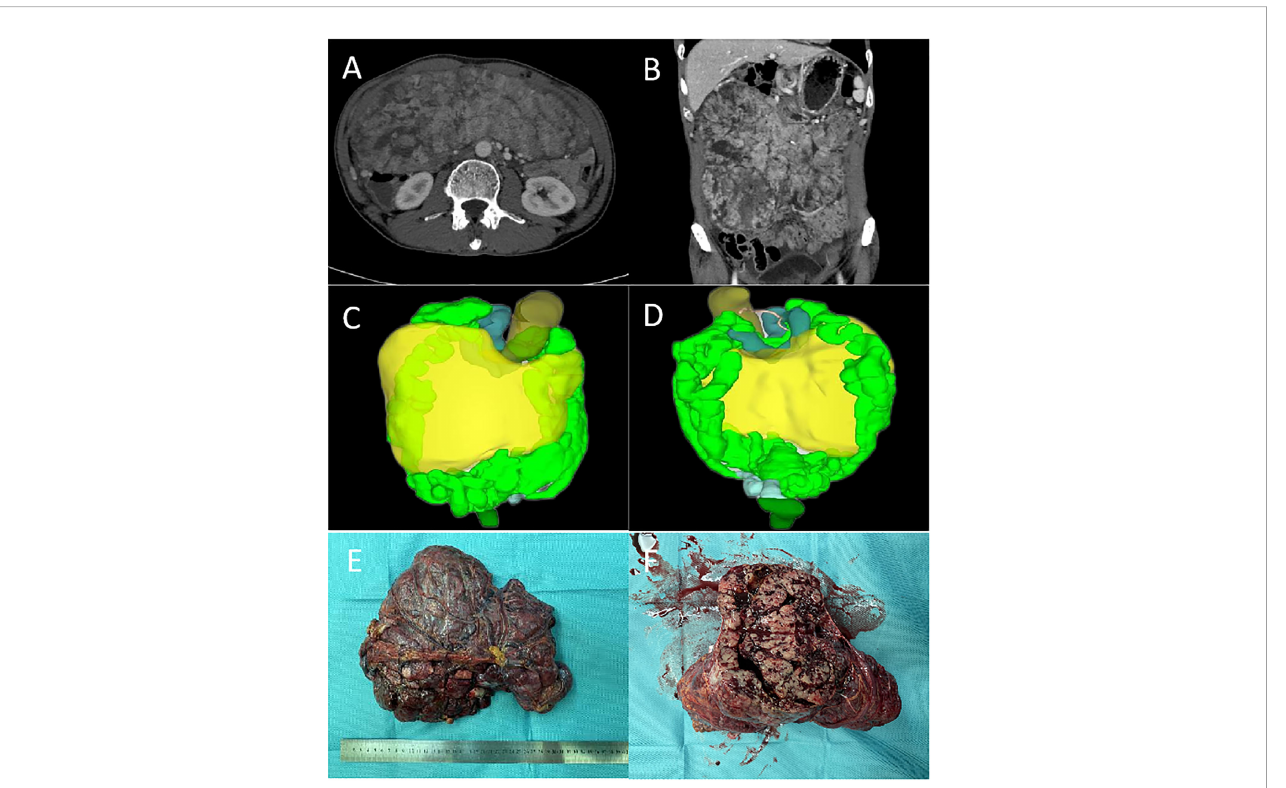
FIGURE 1 The representative pictures of tumors (Case 2): (A, B) , the cross-sectional and coronal views of CT. (C, D) , the front and back of the 3D visualization image. (E, F) , the resected tumor